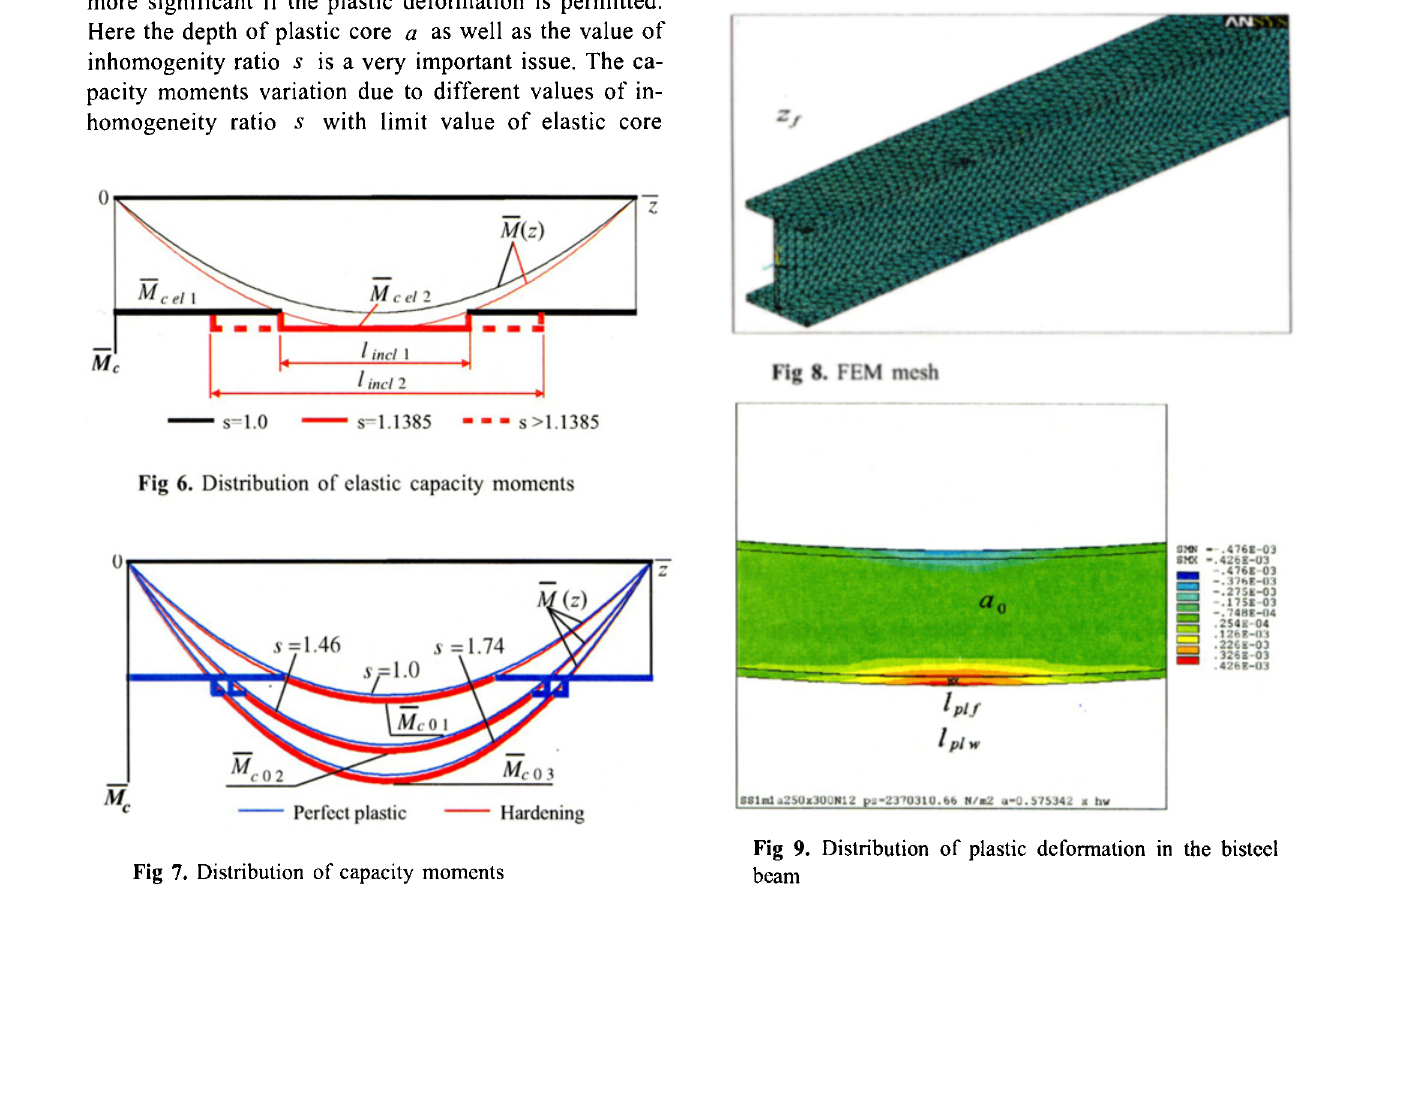
Fig 9. Distribution of plastic deformation in the bisteel